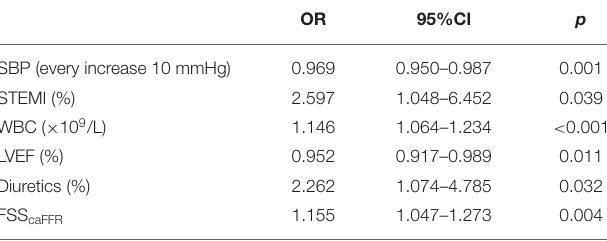
TABLE 3 | Multivariable logistic regression analysis for independent predictors of VT/VF after AMI.